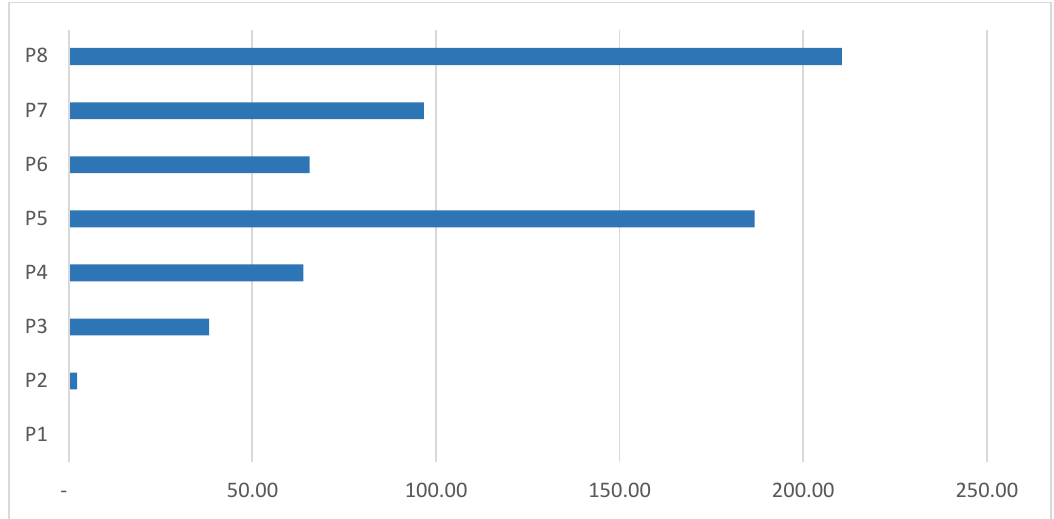
Figure 5. The replacement costs in euro/m 2 for implementing each type of project.